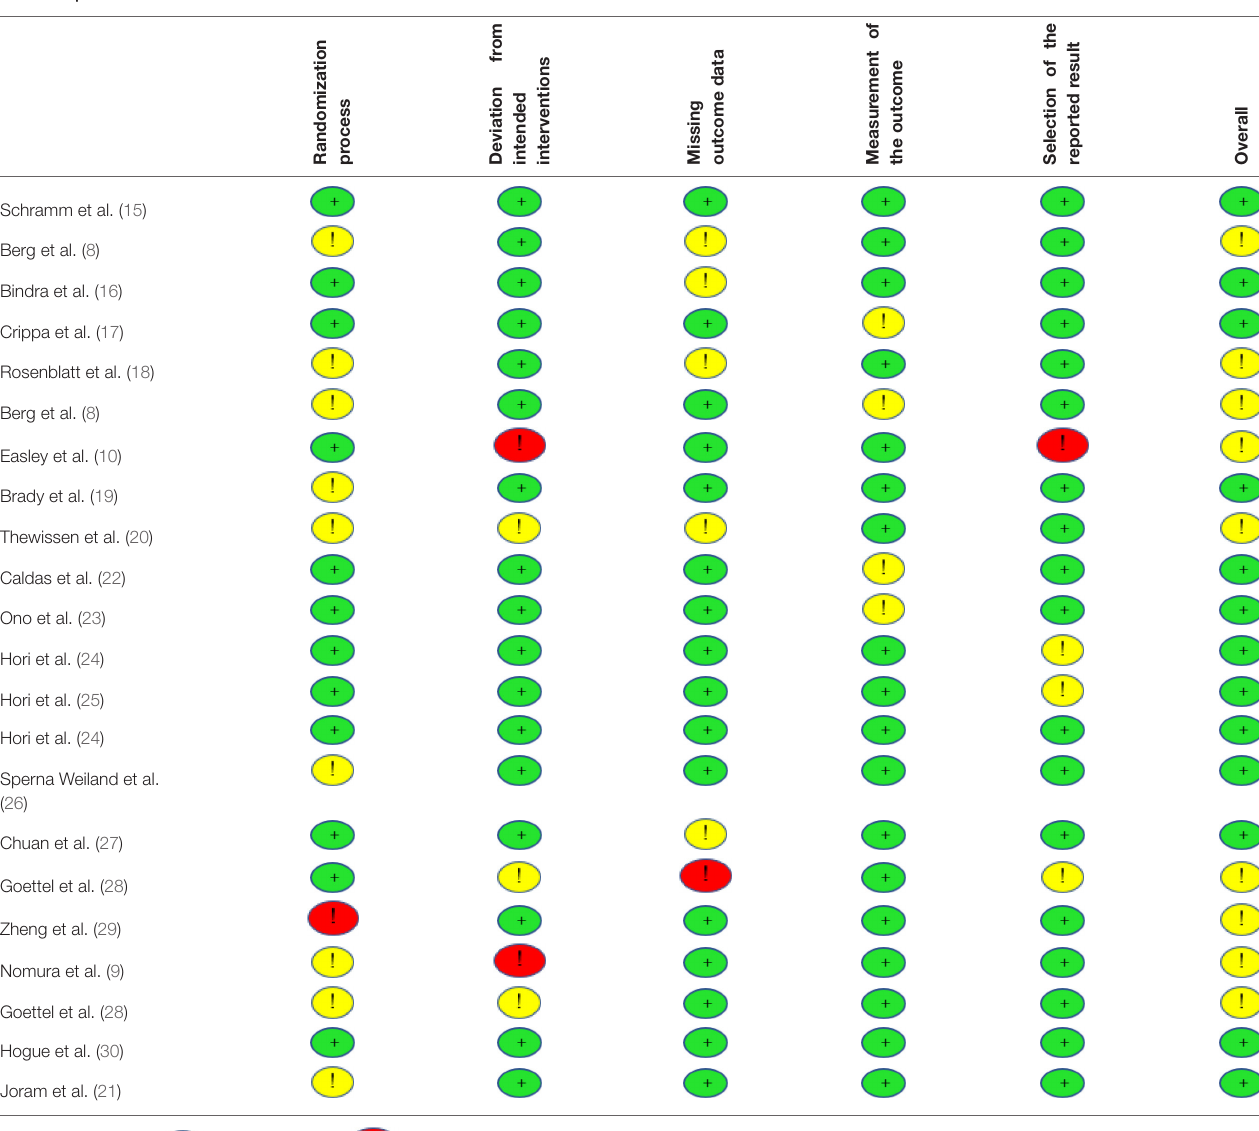
TABLE 4 | Risk of bias